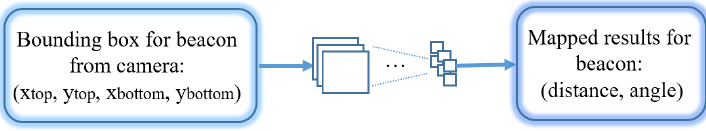
Figure 16. Detection mapping for the camera.